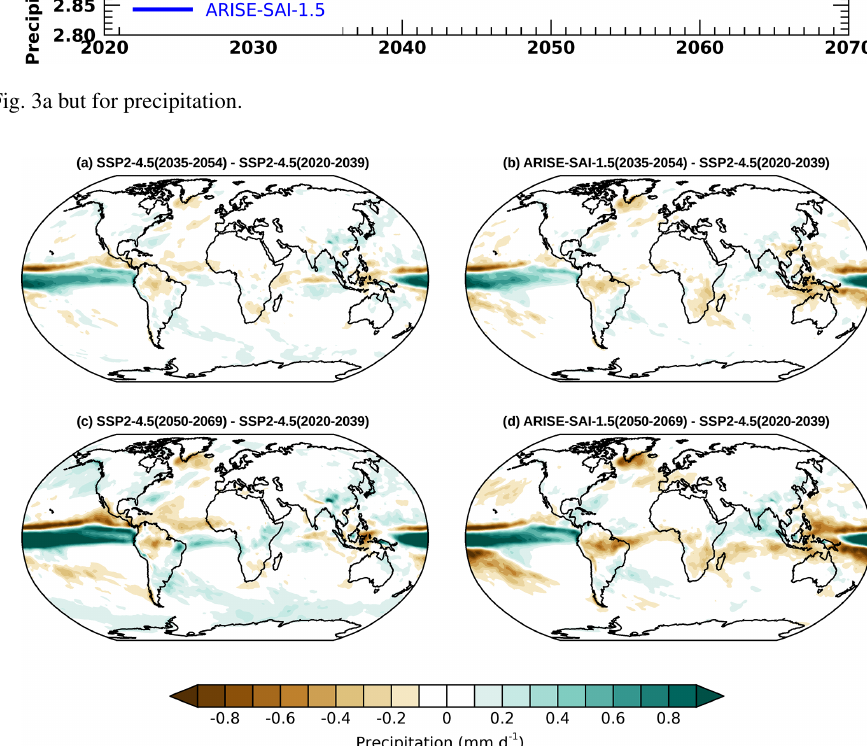
Figure 6. Same as Fig. 4 but for annual mean